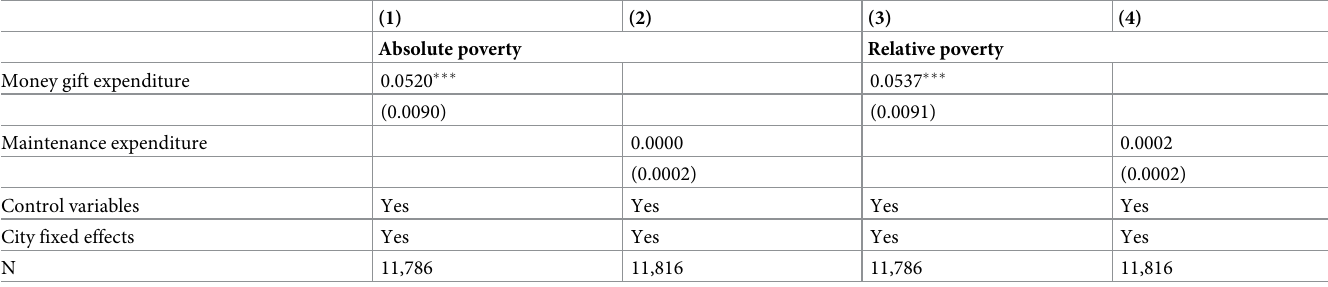
Table 11. Expenses related to social networks and rural household